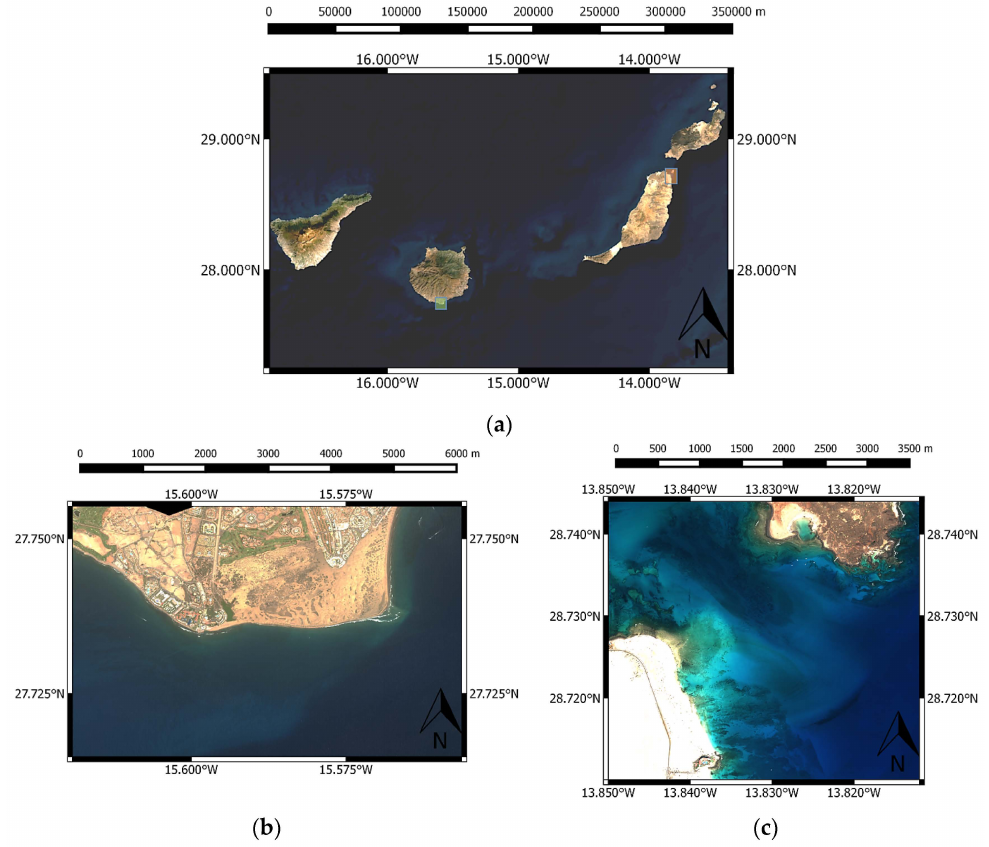
Figure 2. ( a ) Location of study area (The Canary Islands); ( b , c ) WV-2 images of two Canary Islands singular littoral zones: ( b ) Maspalomas (Gran Canaria Island, 11 August 2013) area; and ( c ) Corralejo-Lobo Island (Fuerteventura Island, 28 October 2010)